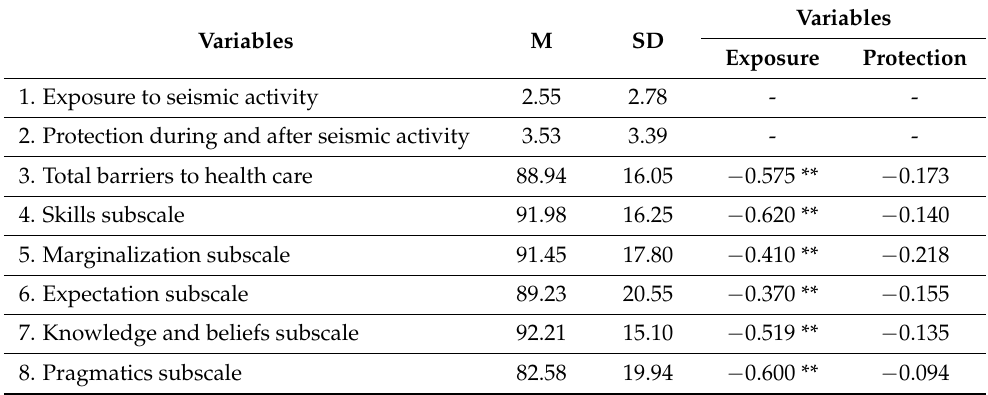
Table 3. Correlation analysis to evaluate the relationship between barriers to care, exposure, and protection ( n =